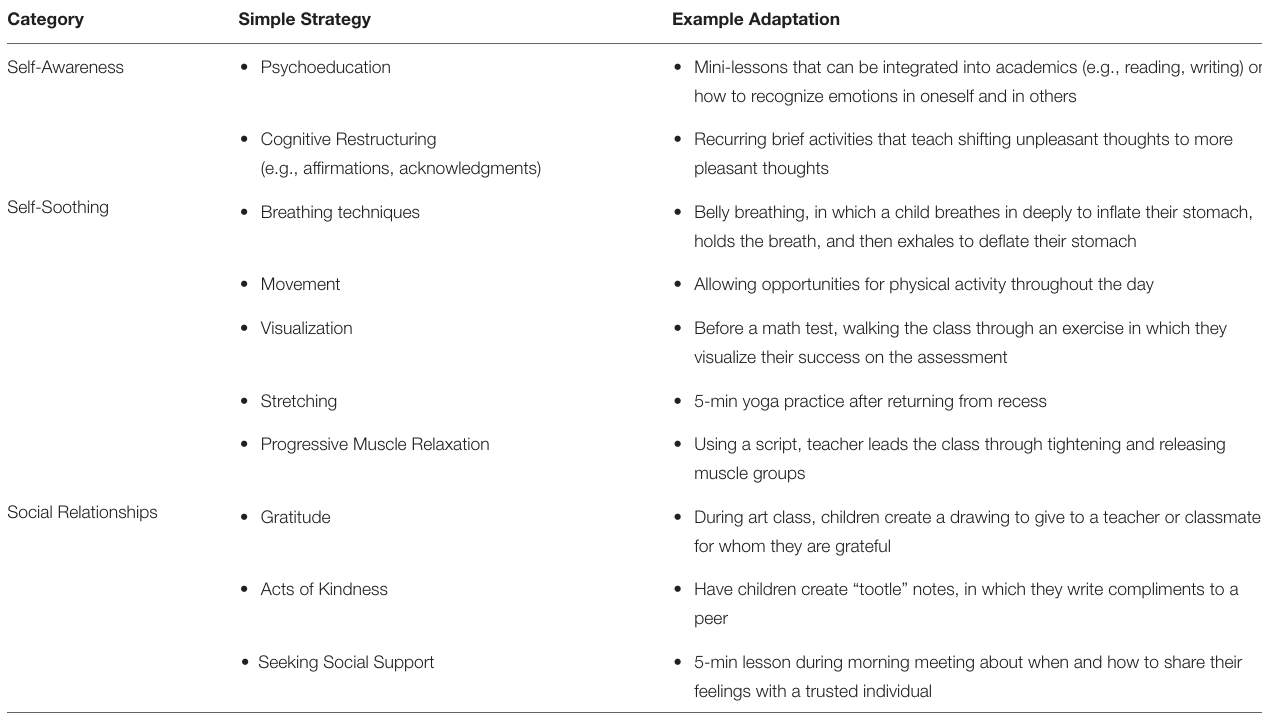
TABLE 2 | Simple strategies to promote child self-awareness, self-soothing, and social relationships. Category Simple